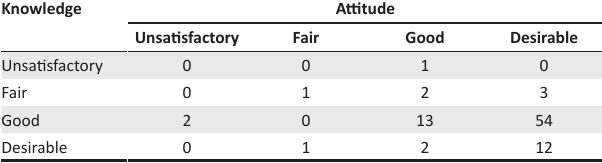
TABLE 6: Association between knowledge and attitude.